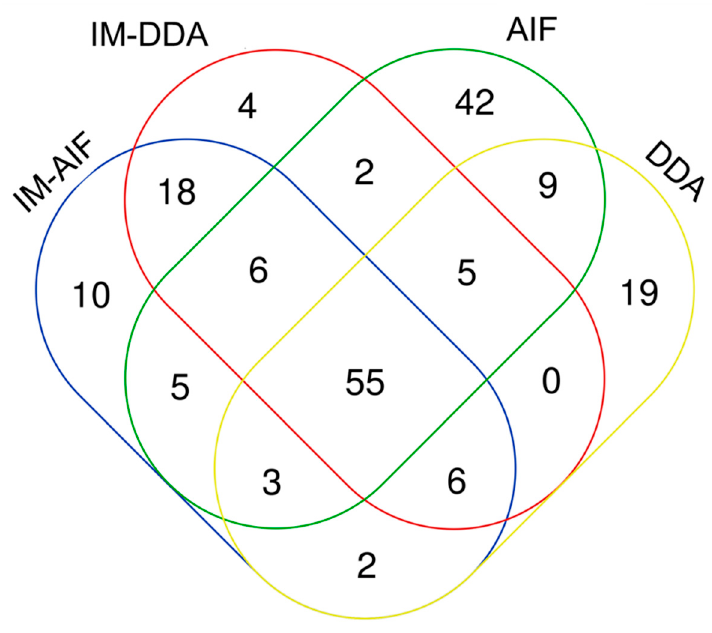
Figure 3. Overall metabolite annotation obtained using IM-AIF, IM-DDA, AIF, and data-dependent analysis (DDA) modalities.